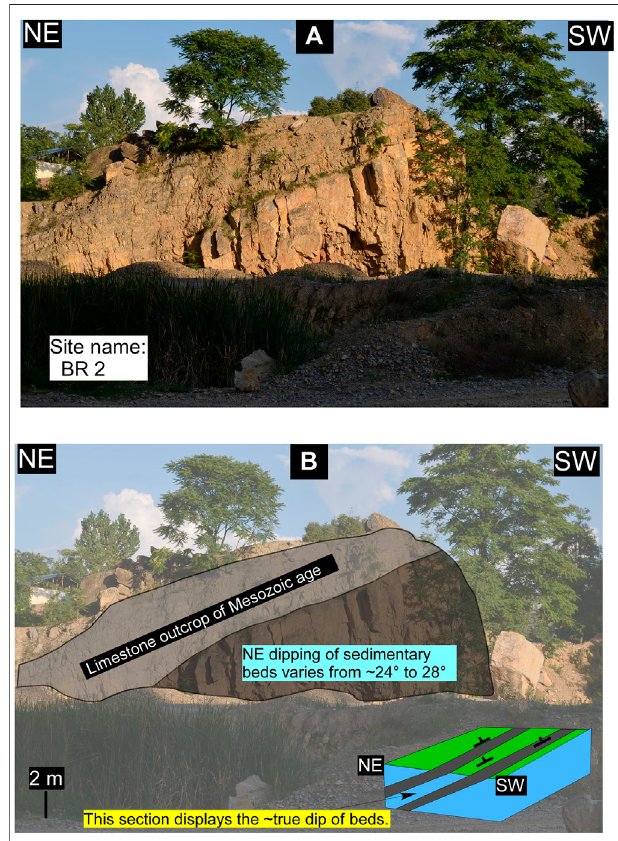
FIGURE 4 | The fi eld evidence shows the Kashmir Tethys (Mesozoic carbonate) basement rocks that are exposed at a quarry section in Anantnag, Kashmir (location in Figure 1 ). The un-interpreted (A) and interpreted (B) fi eld photographs show a vertical section that exposes the true dip of the tilted basement